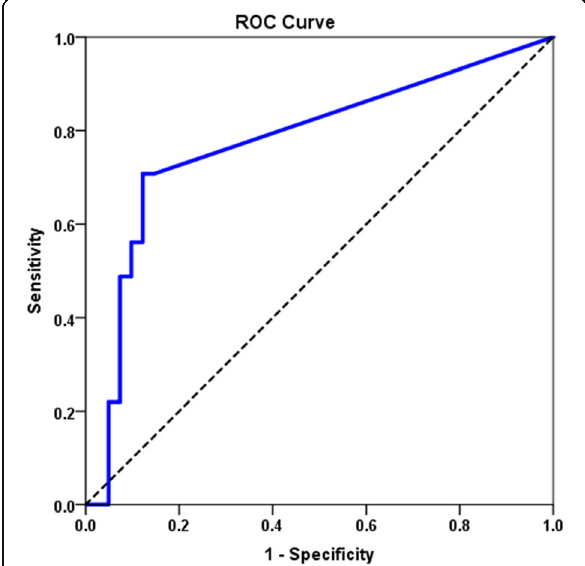
Fig. 3 ROC for serum leptin to discriminate between PICU and ward